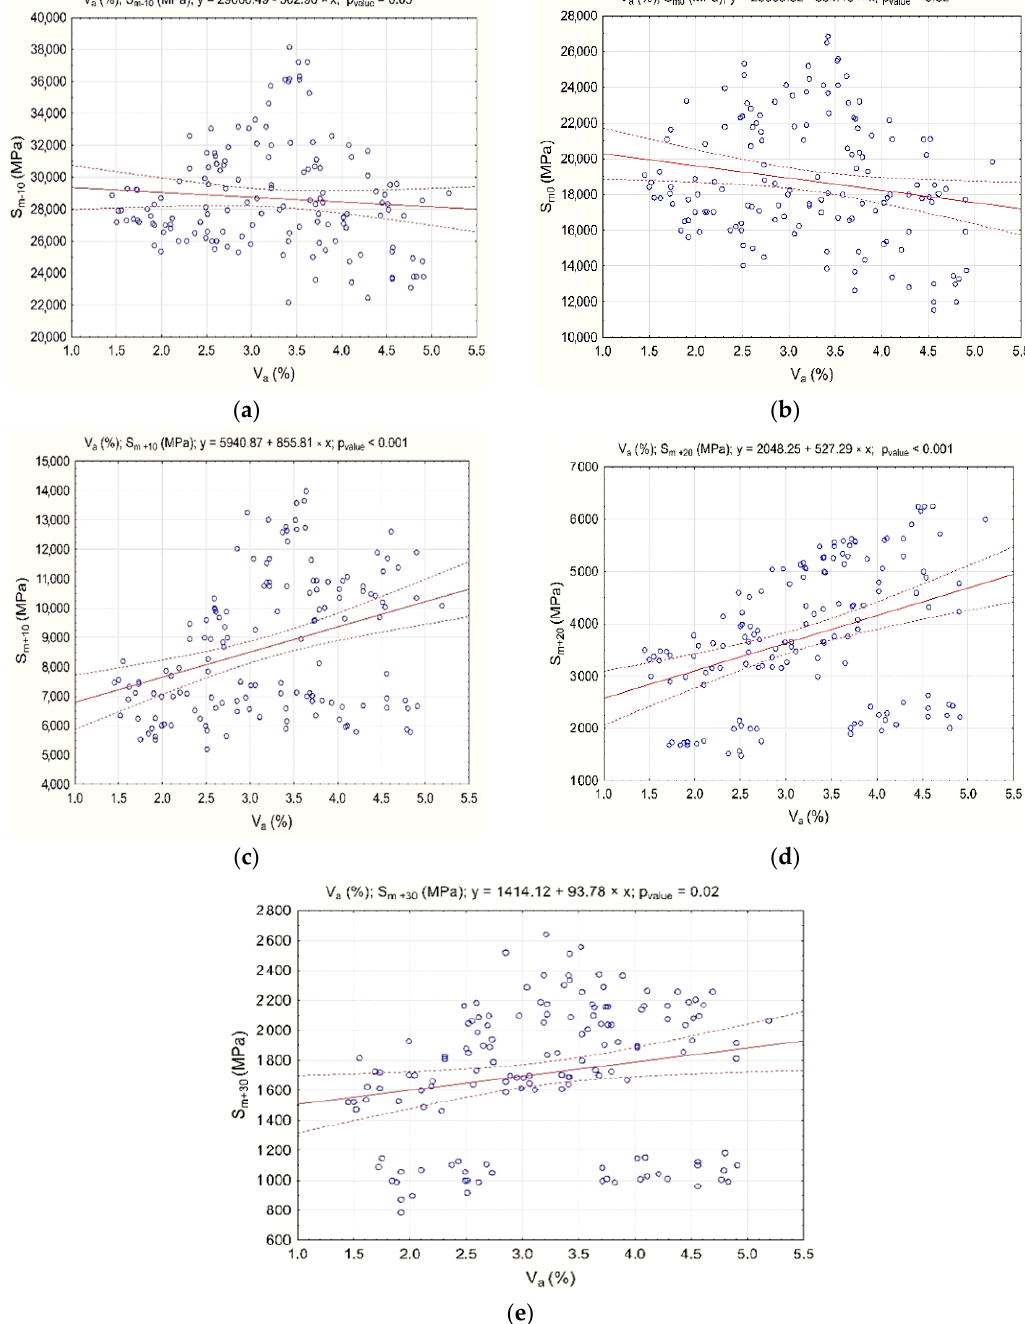
Figure 9. Correlation between AC 8 S mixture air void content (V a ) and stiffness modulus S m ; ( a ) S m-10 , ( b ) S m0 , ( c ) S m+10 , ( d ) S m+20 , ( e ) S m+30 . Dotted lines represent 95% confidence interval.